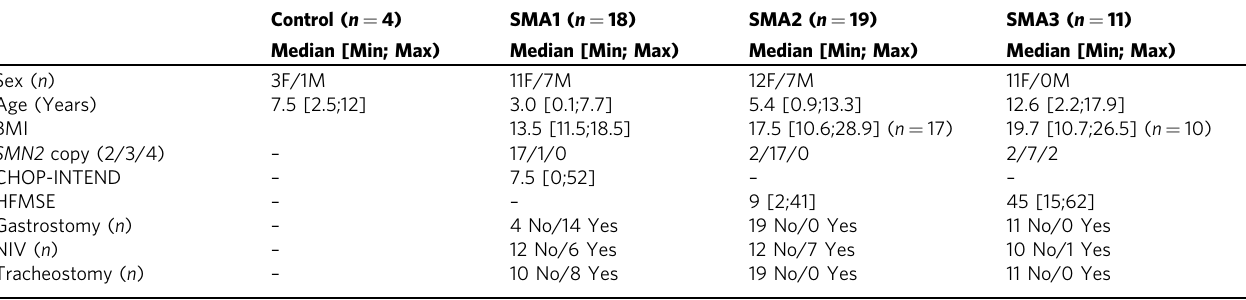
Table 1 Demographic and clinical characteristics of naive SMA subjects (total n = 48) enrolled in the